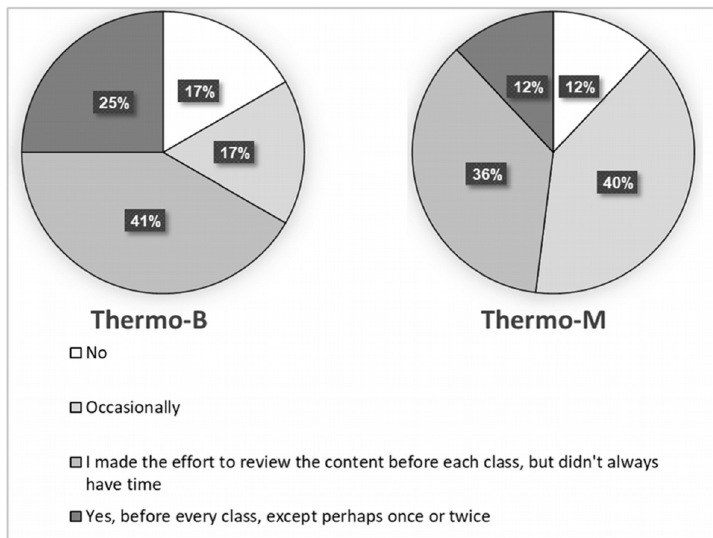
Figure 1. Students’ course content review before